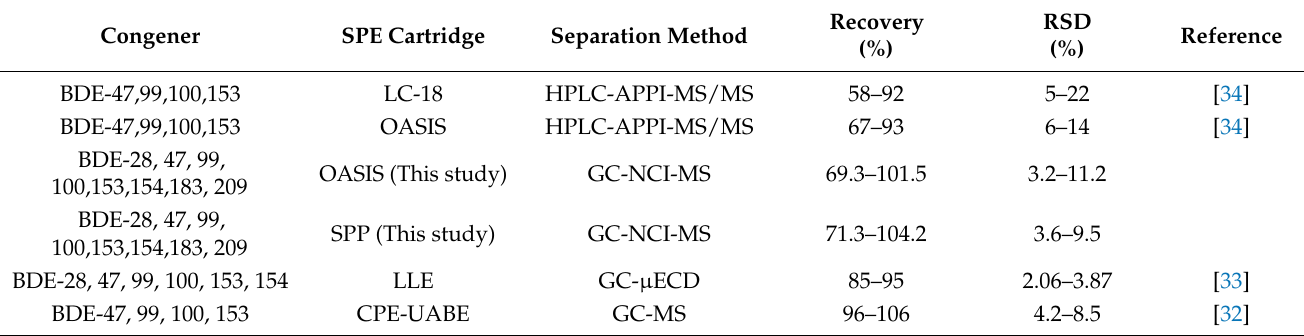
Table 1. Recovery and RSD of PBDEs by different SPE cartridges from water